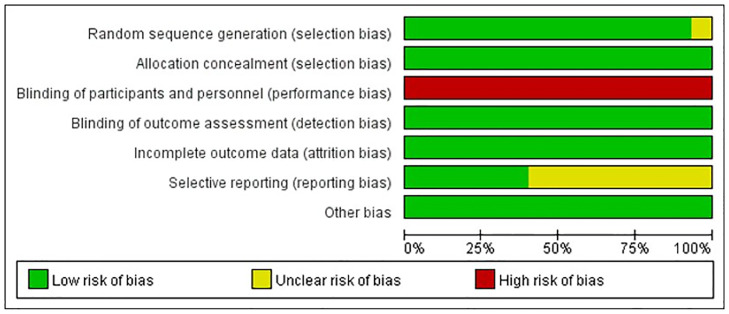
Risk of bias graph.